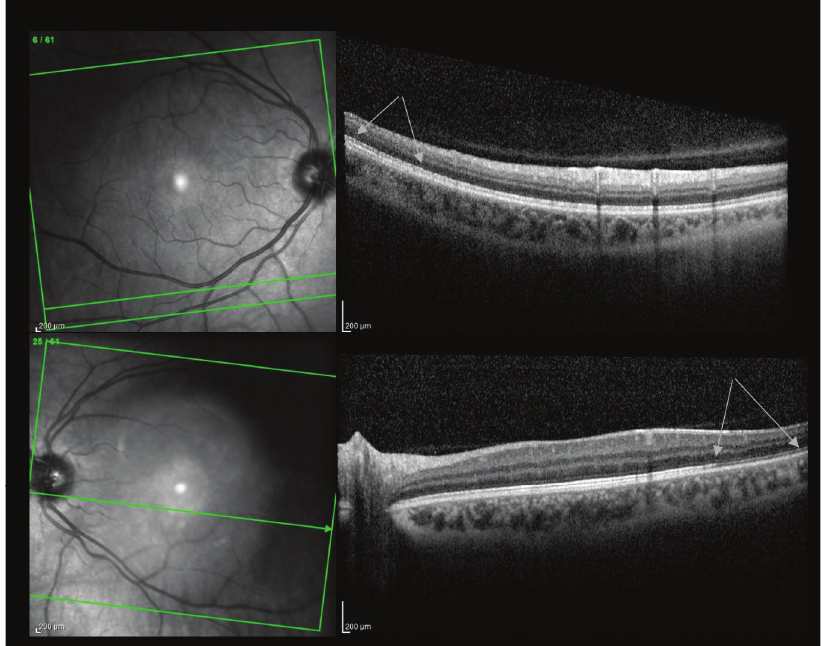
Figure 4. The upper and lower pictures are macular optical coherence tomography of the right and left eye, respectively. Arrows show the areas of disruption and segmentation of the ellipsoid zone in the right eye and thinning of (absent in some areas) ellipsoid zone in the left